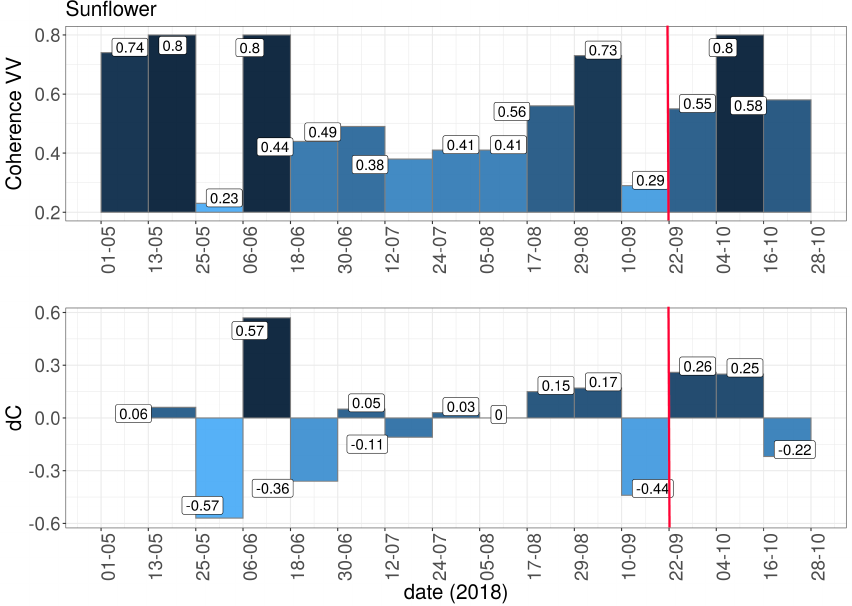
Figure 6. Example of vertical receive (VV) coherence time series and its first differences ( dC ) for